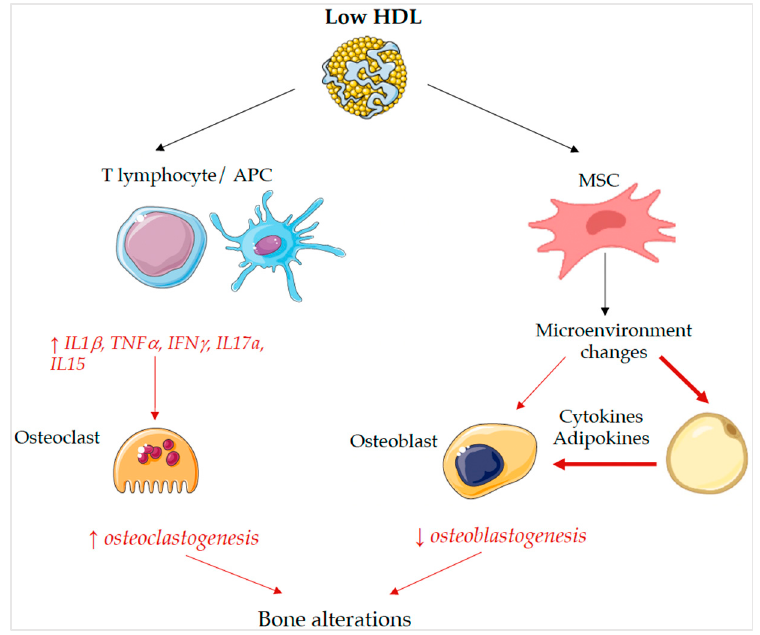
Figure 2. Molecular mechanisms that link low HDL-c levels to bone alterations. For full description, see text. Abbreviations: HDL: high-density lipoprotein cholesterol; APC: antigen presenting cell; MSC: multipotent mesenchymal stem cell.